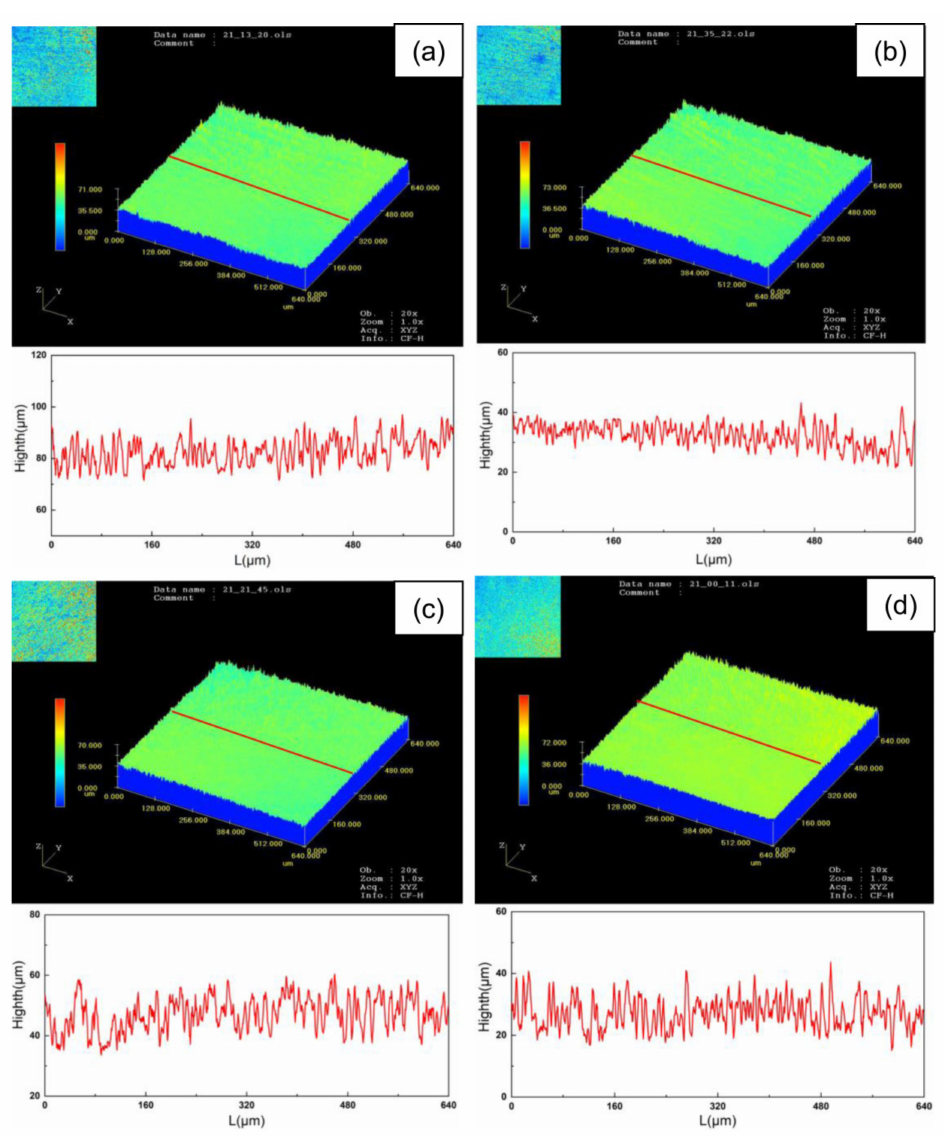
Figure 12. Surface morphology of oxide film at different heating times: ( a ), ( c ) mechanical grinding at 0.5 and 2 h, ( b ), ( d ) laser cleaning at 0.5 and 2